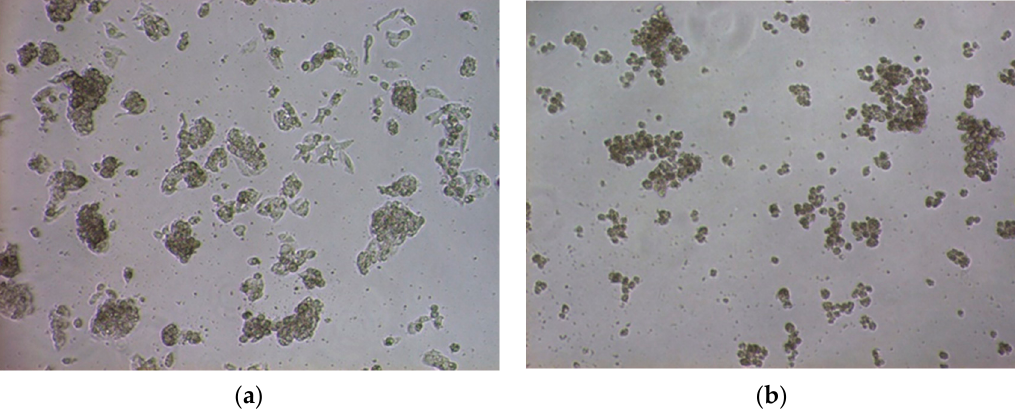
Figure 3. ( a ) Microscopy image of control HepG2 cells; ( b ) image of 10 mM cocaine-treated HepG2 cells (magnification 10 × 10×).